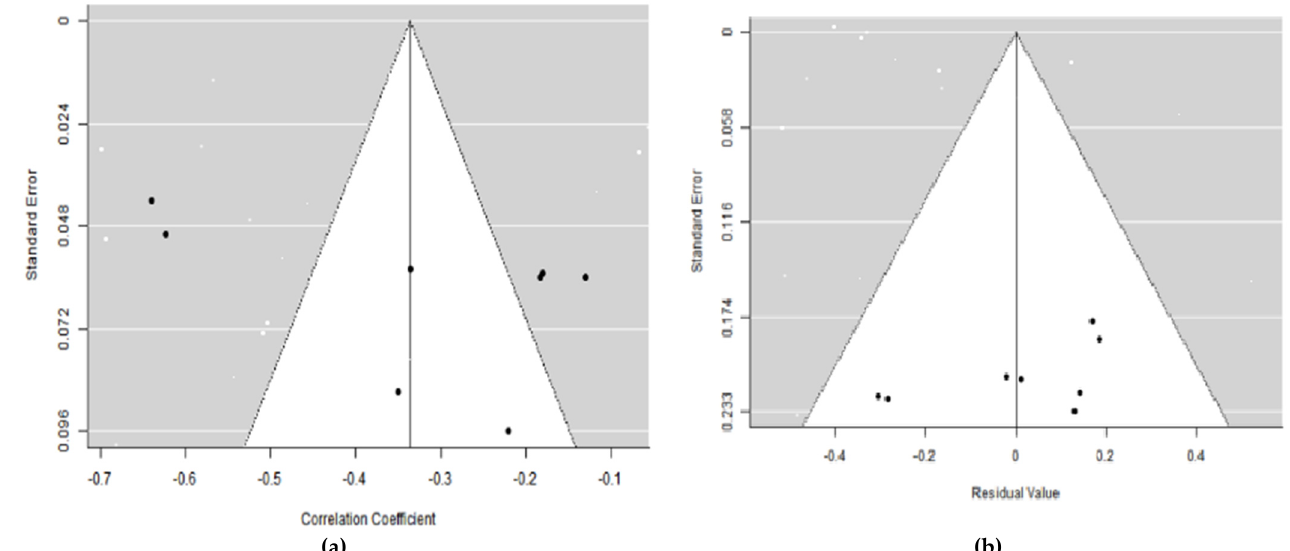
Figure 3a, b. Funnel plot with REM and mixed